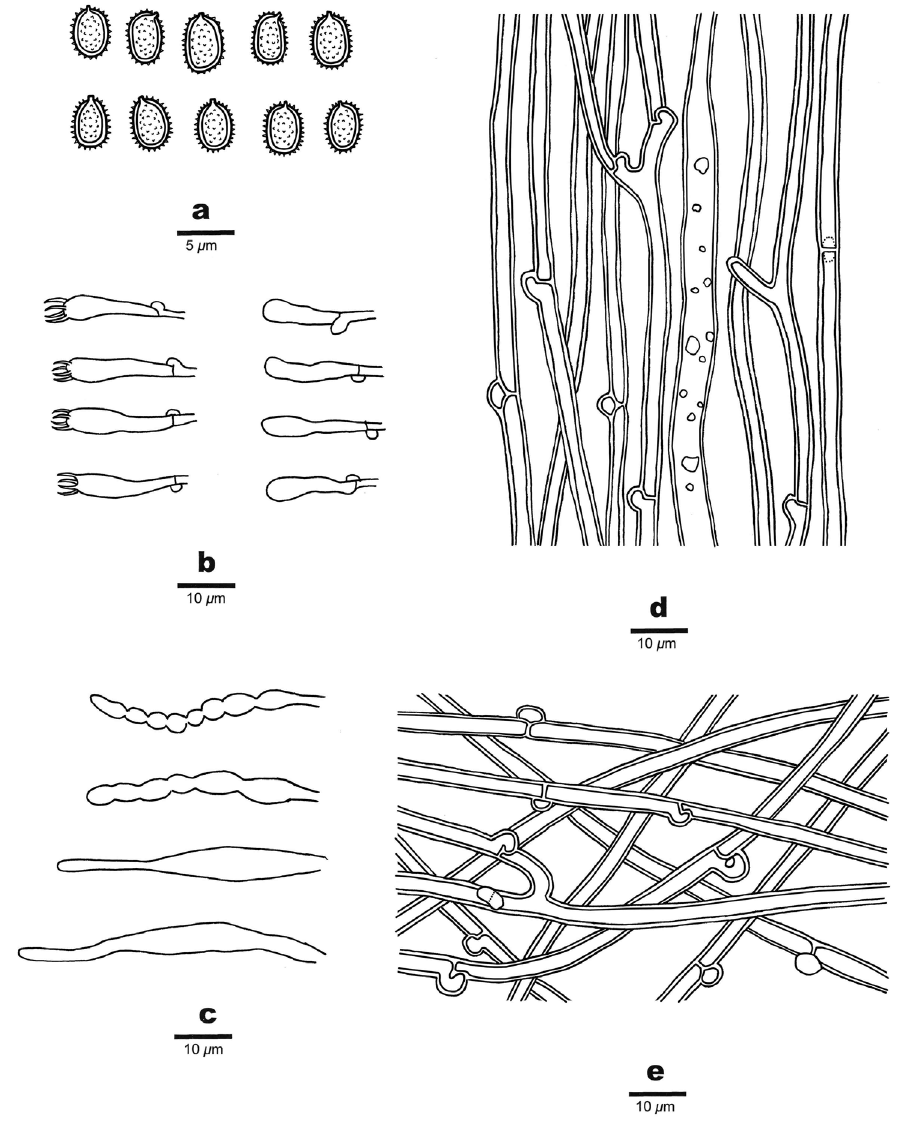
Figure 3. Microscopic structures of Dentipellis tasmanica (holotype). a Basidiospores b Basidia and ba- sidioles c Gloeocystidia and Cystidioles d Hyphae from trama e Hyphae from subiculum. vs. 3.2–4 1 × 2.4–3 µm, Ginns 1986), but gloeocystidia and gloeoplerous hyphae in D. leptodon are yellowish in Melzer’s reagent and it lacks chlamydospores in subiculum. Phylogenetically, Dentipellis tasmanica is more closely related to D. rhizomorpha Yuan & Y.C. Dai , D. fragilis , D. dissita and D. longiuscula (Fig.1). However, D. rhizomorpha has denser spines (5–7 per mm vs. 2–3 per mm in D. tasmanica ), lacks gloeoplerous